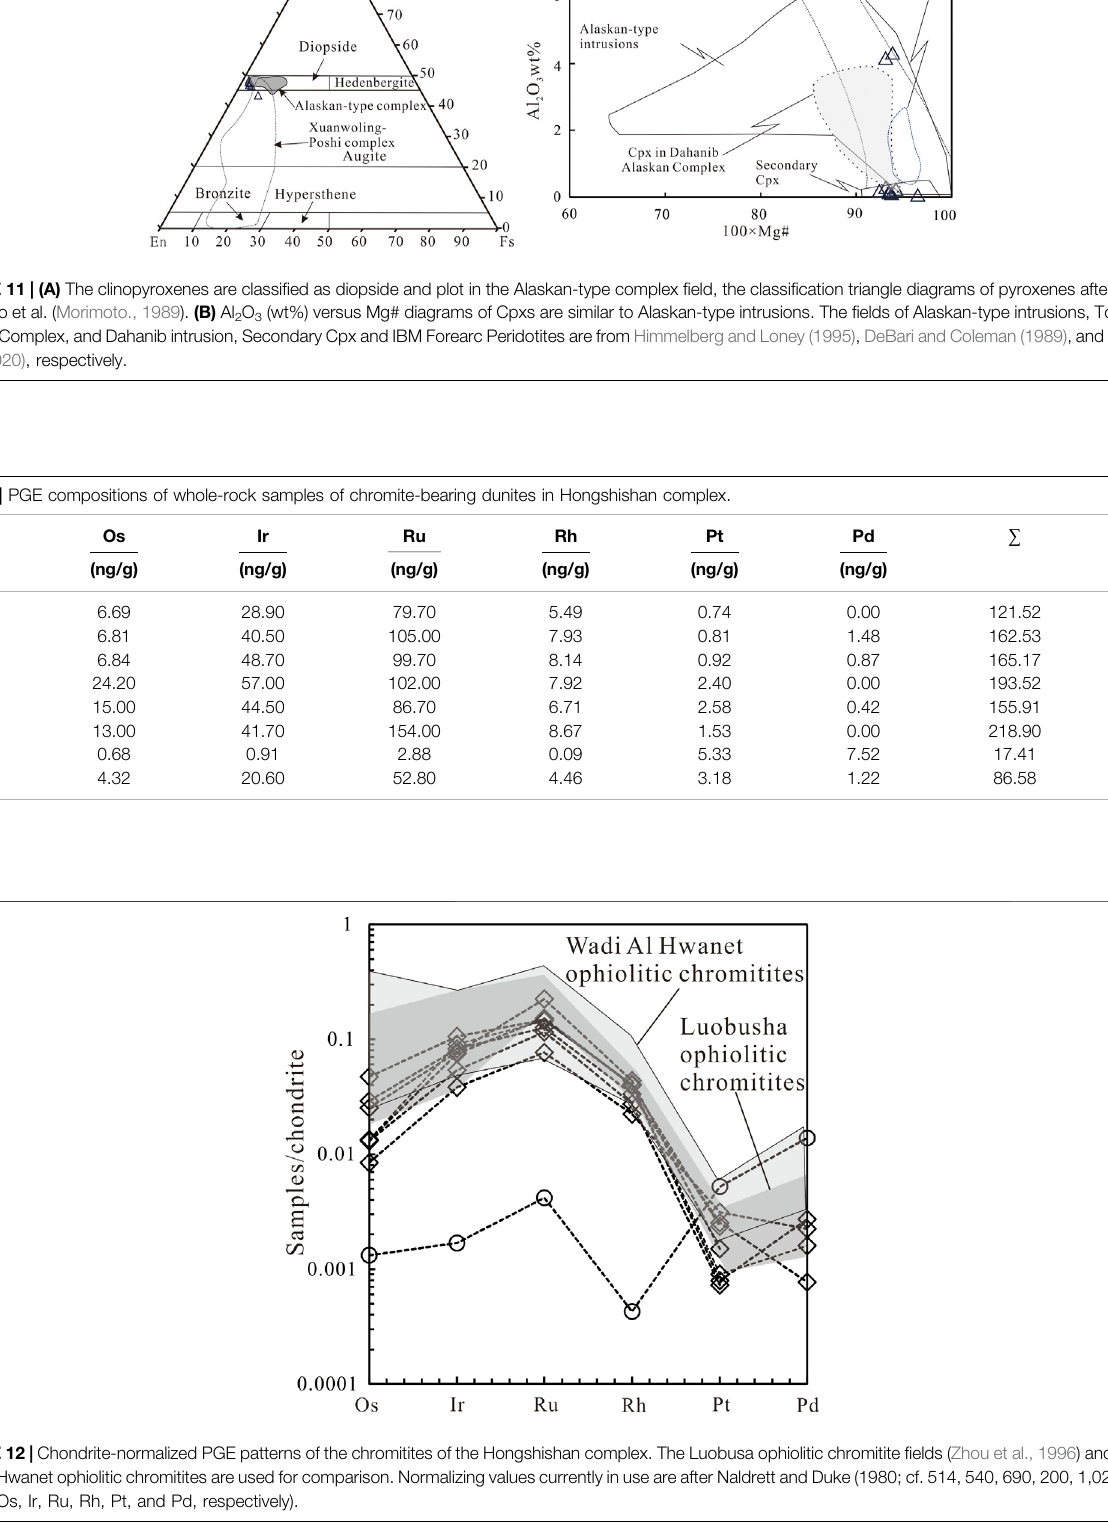
Frontiers in Earth Science |